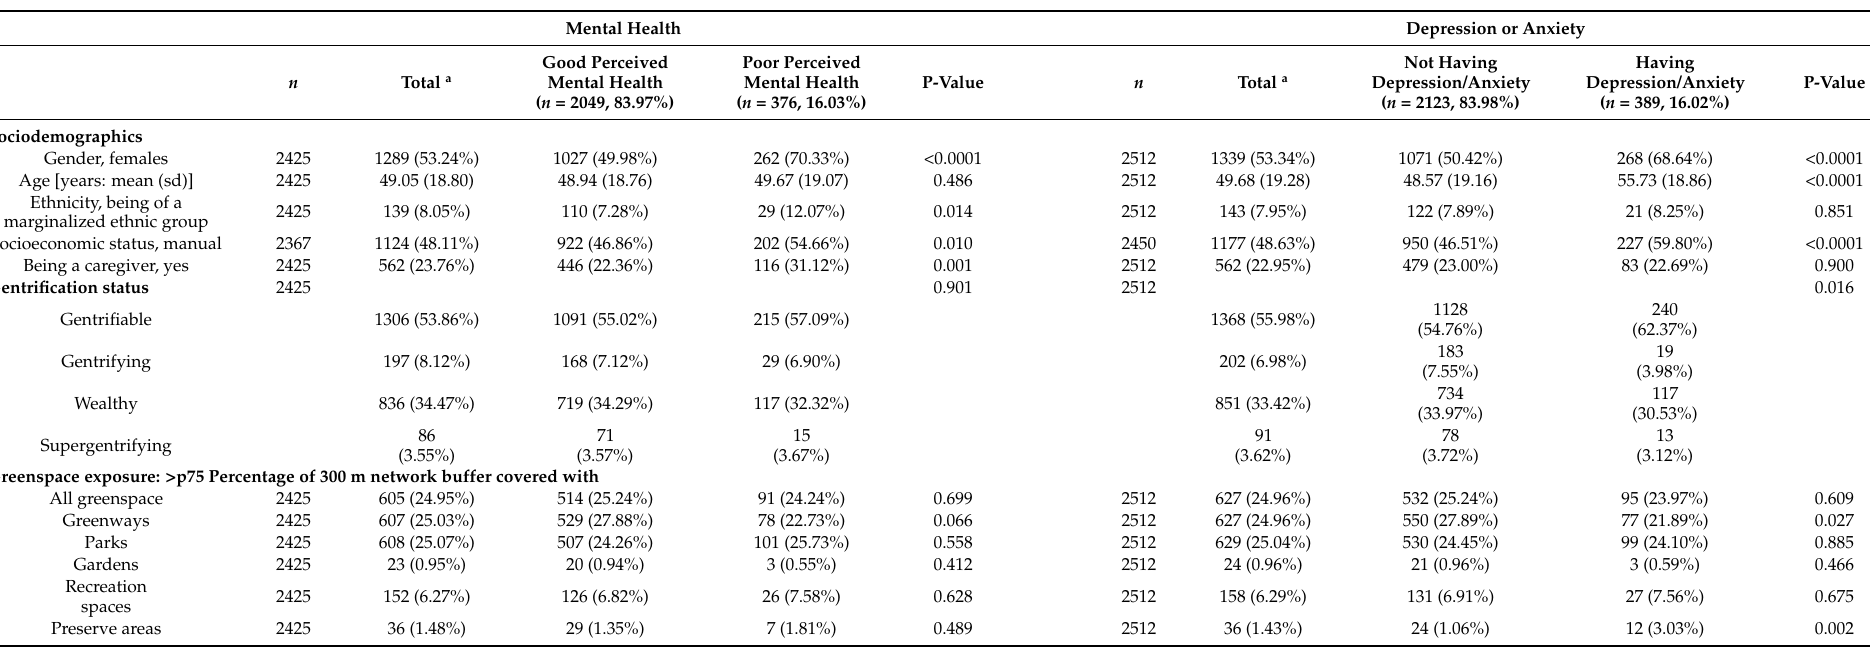
Table 1. Characteristics of study participants for all sociodemographic, gentrification status and greenspace variables by perceived mental health status and depression/anxiety (weight-adjusted).